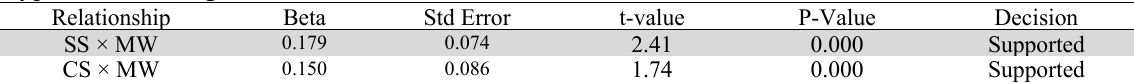
Hypothesis Testing- Moderation Results